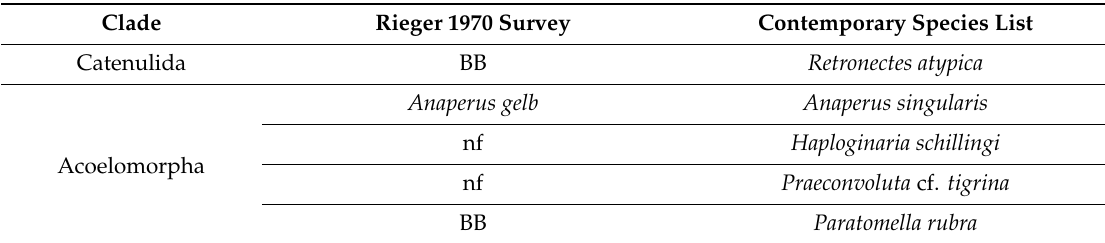
Table 3. Comparison of turbellarian species found within the last decade at ISP to those in collections made in the same location or nearby beaches in the 1970s. “BB” = found by Rieger at other sites on Bogue Banks; “nf” = not found; “OTU” = not observed alive, but present in OTUs from ISP (see Section 3.5); “spp.” = at least two congeners appear in metabarcoding data. Names of undescribed taxa used here are labels and not being made available for formal taxonomic purposes.